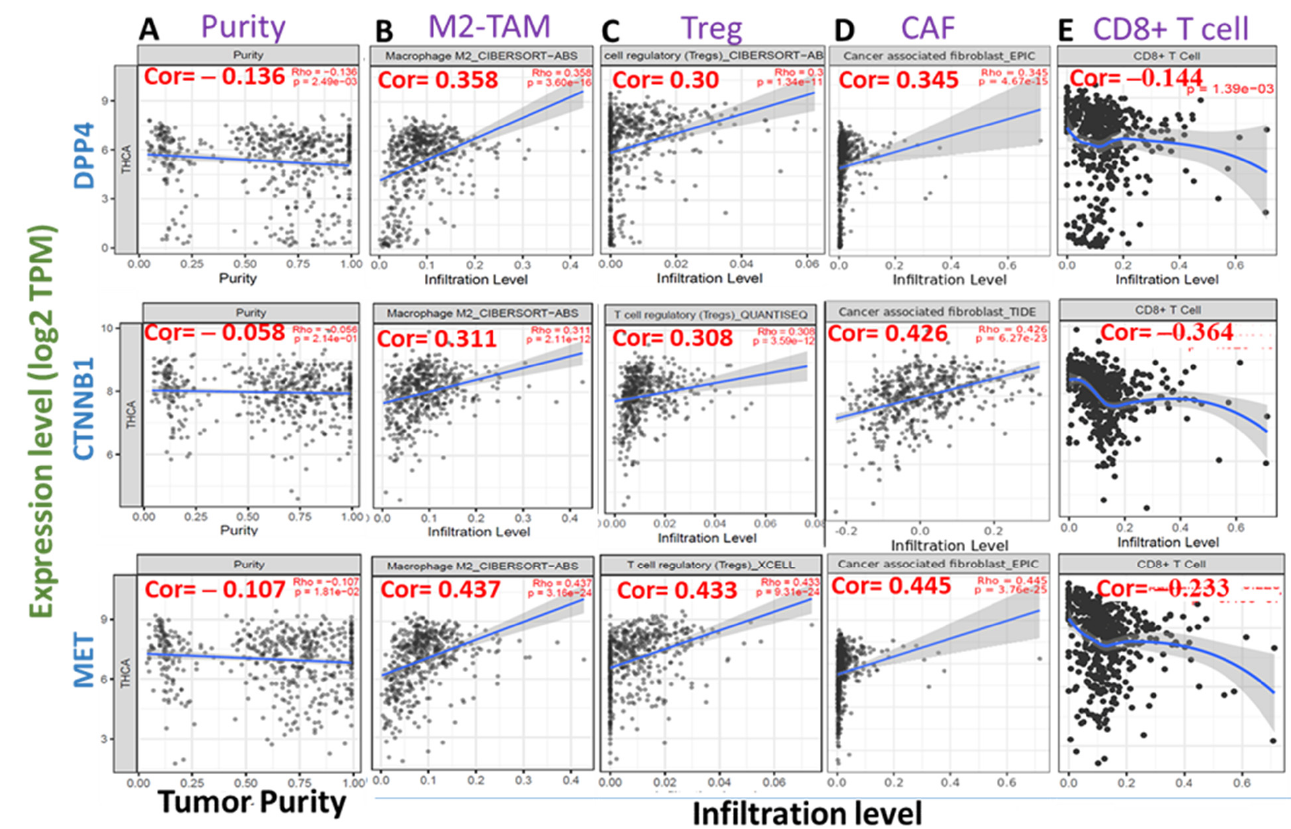
Figure 5. High expression levels of DPP4/CTNNB1/MET are associated with immunosuppressive phenotypes of THCA tissues. Scatterplots of DPP4/CTNNB1/MET expression correlations with ( A ) tumor purity, and infiltration levels of ( B ) tumor-associated macrophages (M2 TAM), ( C ) regulatory T cell (Treg), ( D ) cancer-associated fibroblast (CAF), and ( E ) CD8 + T cell. The strength of correlations between the genes and immune cells is reflected by the purity-adjusted partial Spearman’s rho value, where a value of r ≥ 1 means a perfect positive correlation and a value of r ≤ − 1 means a perfect negative correlation, with p < 0.05 considered statistically significant.